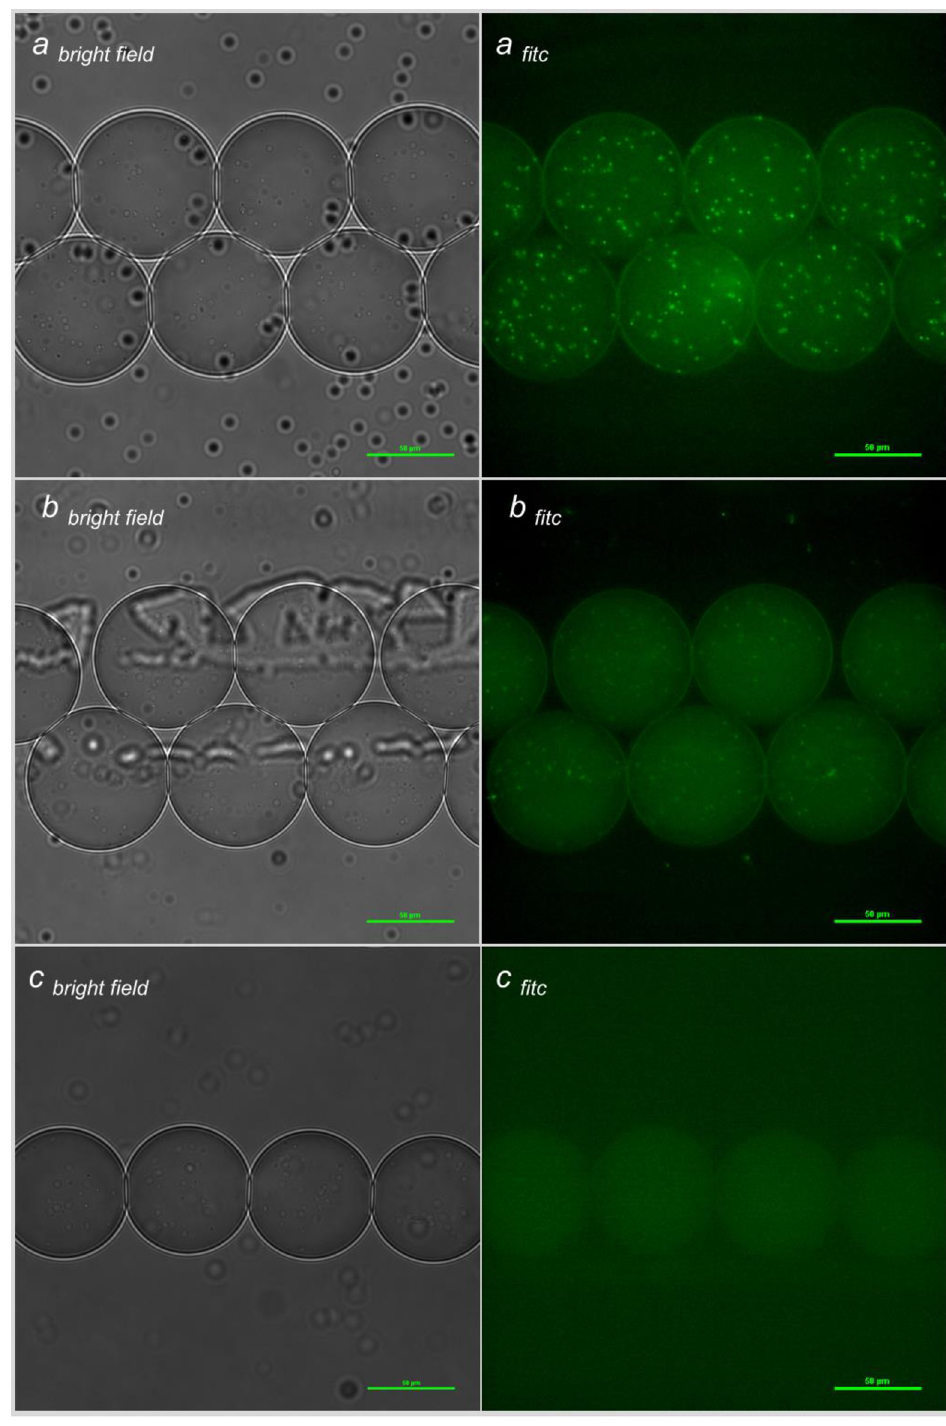
Fig 4. Bacterial species ( a : S . Typhimurium ; b : E . aerogens; c : C . freundii ) with 0.83 μ g/ml FITC-Ab in phosphate buffered saline.) each droplet is approximately 50–70 μ m in diameter (scale on image is 50 μ m). Bright field images are presented complimentary to FITC images and visually show bacterial concentration at an ideal focal plane (5 μ m interval stacking and merging of images into two dimensional images is not optimal for bright field images). FITC images are merged 5 μ m interval focal plane images and represent a two-dimensional image of the entire droplet.